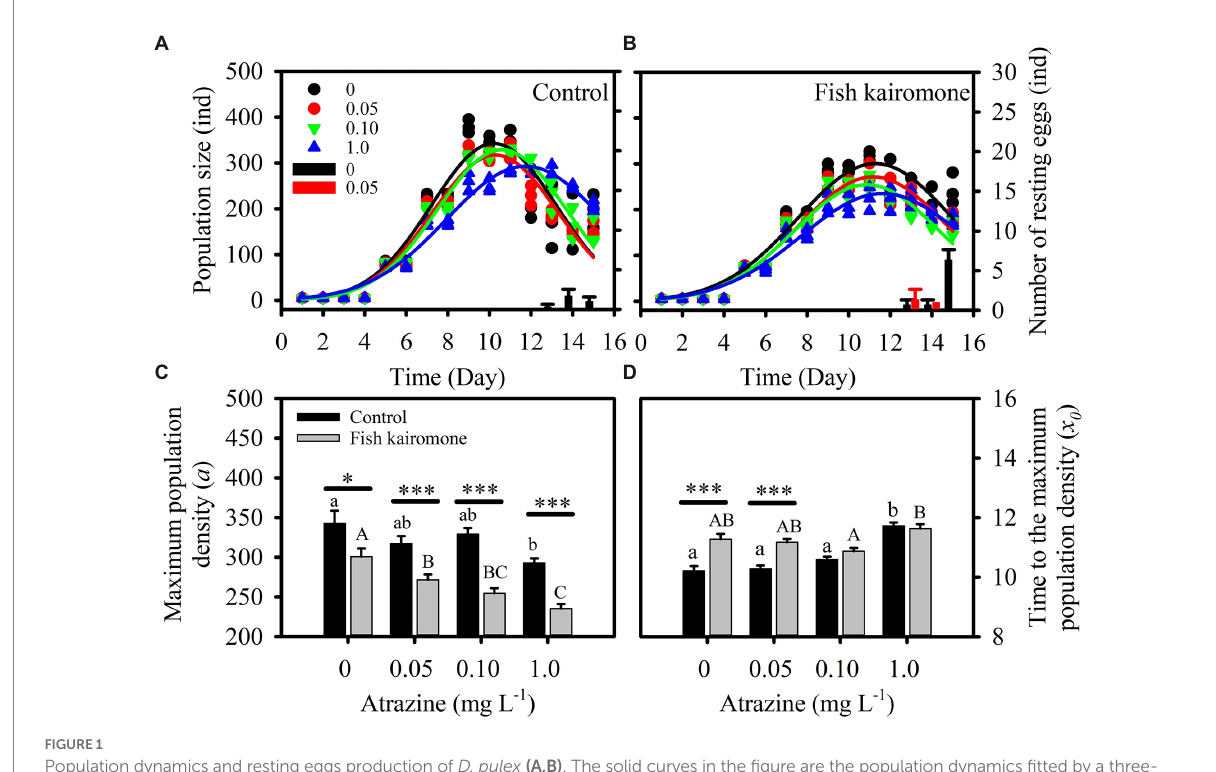
FIGURE 1 Population dynamics and resting eggs production of D. pulex (A,B) . The solid curves in the figure are the population dynamics fitted by a three-  −  x x −   = × parameter Gaussian model, i.e., , and the columns represent the daily production of resting eggs. D. pulex began to b    produce resting eggs from day 13. Resting eggs are produced only in the two lowest atrazine concentrations, and the black and red bars represent daily resting eggs production at 0 and 0.05 mg L − 1 atrazine concentrations, respectively. (C,D) The population parameters of D. pulex in different treatments. Asterisks indicate significant differences between the control and kairomone treatment ( * p < 0.05, *** p < 0.001), and lowercase and uppercase letters indicate differences among the control and fish kairomone treatment, respectively. The error bars indicate standard